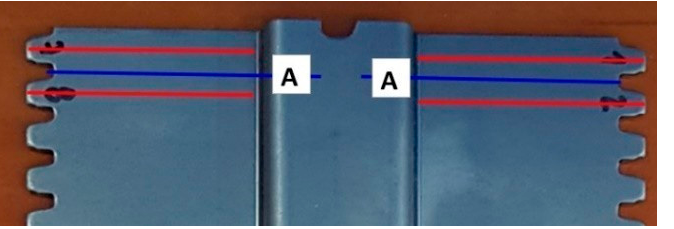
Figure 3. The symmetry of the teeth on the left and right side defined as a phase shift of max. 0.05 mm (own study), A denotes symmetry line. The contour is measured from the distant points every 0.01 mm (about 500 points). It results from the adopted magnification and resolution of the optical system. The distance between the axes is the value of the tooth spacing 10 ± 0.05 mm. The height of the tooth was measured such that a point was acquired at the edge marked with a green area, and this point was set as the zero point. The point at the apex of the tooth was then collected. The value of this quantity determined the tooth height of 5 ± 0.08 mm.